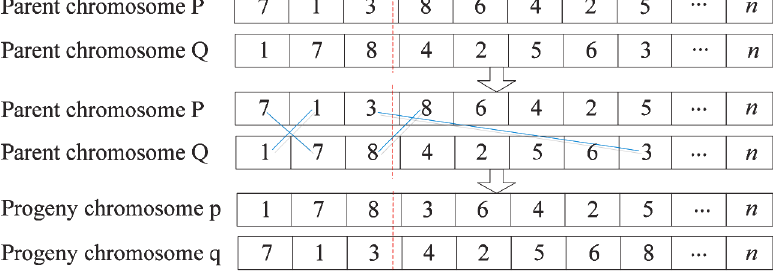
Figure 3. Detailed principle of improved SPMCM